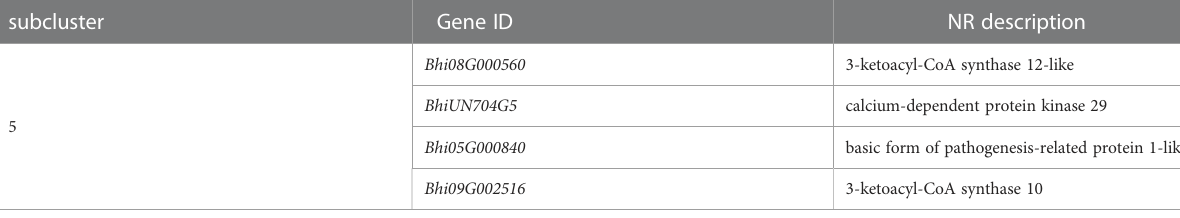
TABLE 2 Genes in subcluster 5 of plant pathogen interaction pathway.